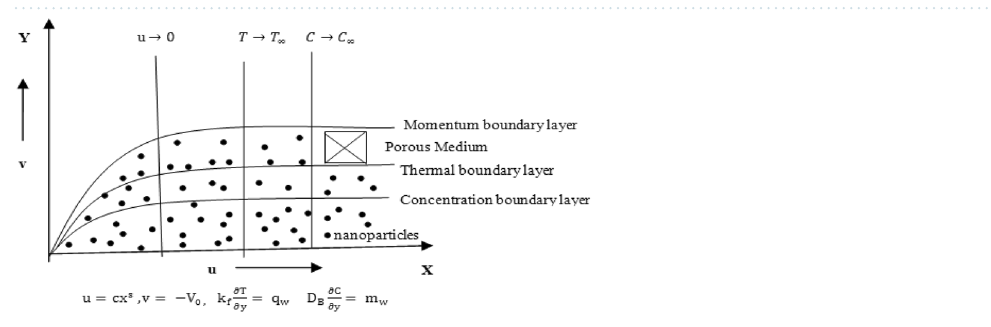
Figure 1. Physical illustration and coordinate of the